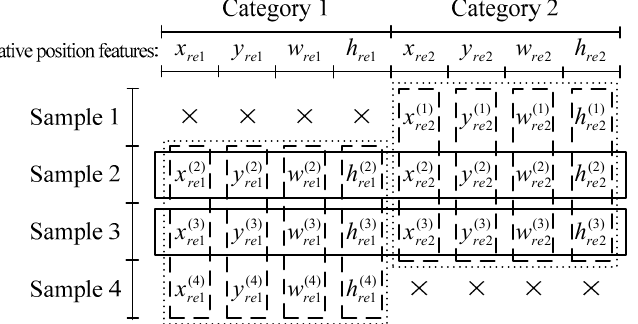
Figure 3. A simple case of missing values. A symbol “×” represents a missing value in the corresponding feature.